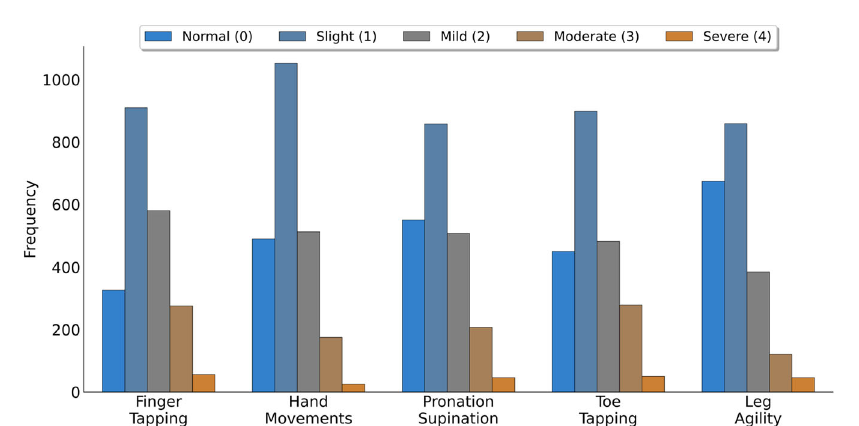
Fig. 1 The distribution of MDS-UPDRS ratings for the fi ve bradykinesia items. In each case the modal rating was Slight (1) and the least common rating Severe